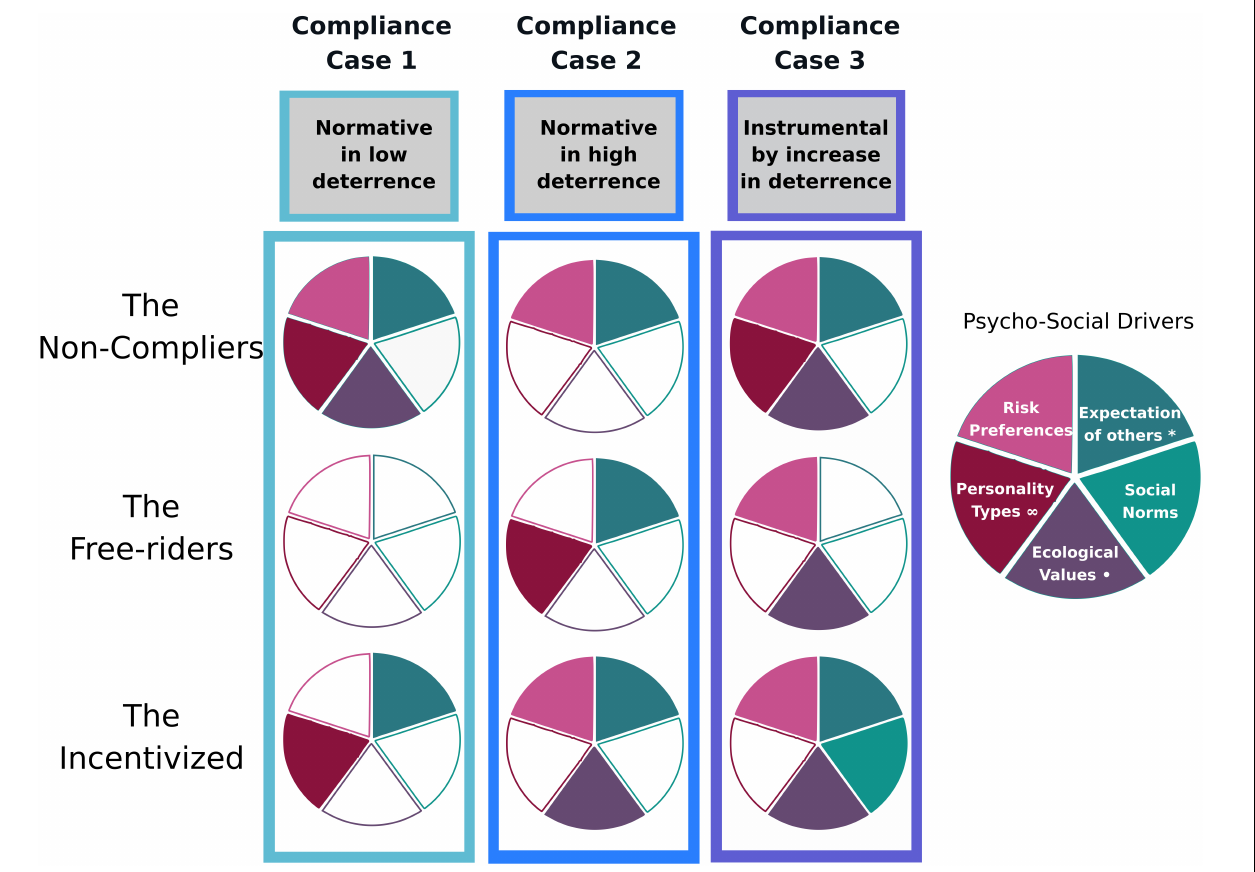
FIGURE 5 | Conceptual summary of the results. Shaded segments indicate if one of the factors included in the umbrella factors was significant and left unshaded if not significant. * Expectation of others combines the results of base scenario and comparison scenario, Ecological values represents both rejection of human exemptionalism and environmentalism, and ∞ Personality types includes all five personality